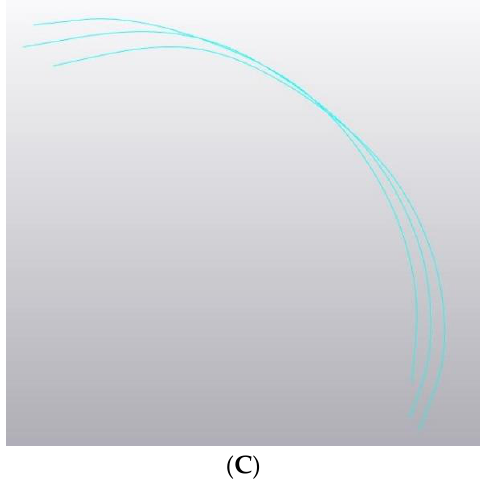
Figure 7. ( A ) Trochlea extracted on a Statistical Shape Model; ( B ) spline of the Trochlea projected on the sagittal plane; ( C ) comparison of trochlea splines for 3 SSM sizes. Splines of the center of the femoral canal in the frontal and sagittal planes were depicted for SSMs of different sizes (Figure 8) and are a useful input for defining the optimal curvature of long stems.